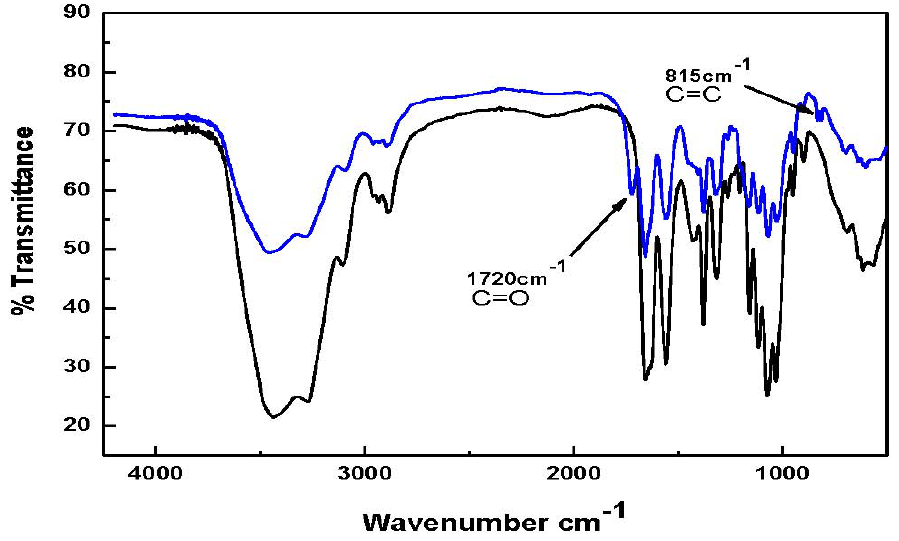
Figure 3. 1 H-NMR of chitin-methacrylate in D